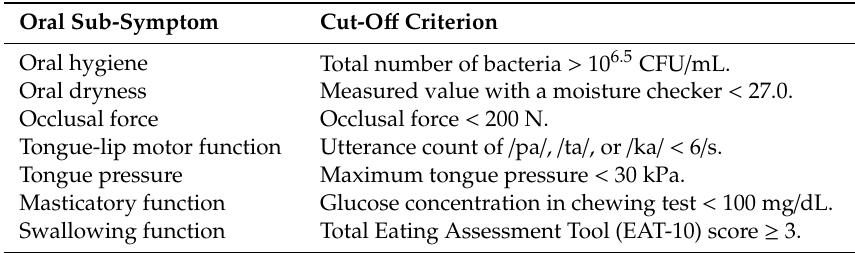
Table 3. Seven oral sub-symptoms of OHF and their criteria